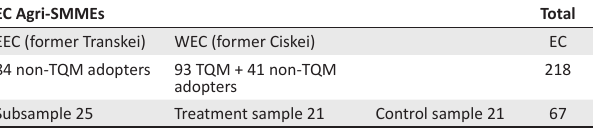
TABLE 1: Agricultural small-, micro- and medium-sized enterprises setting